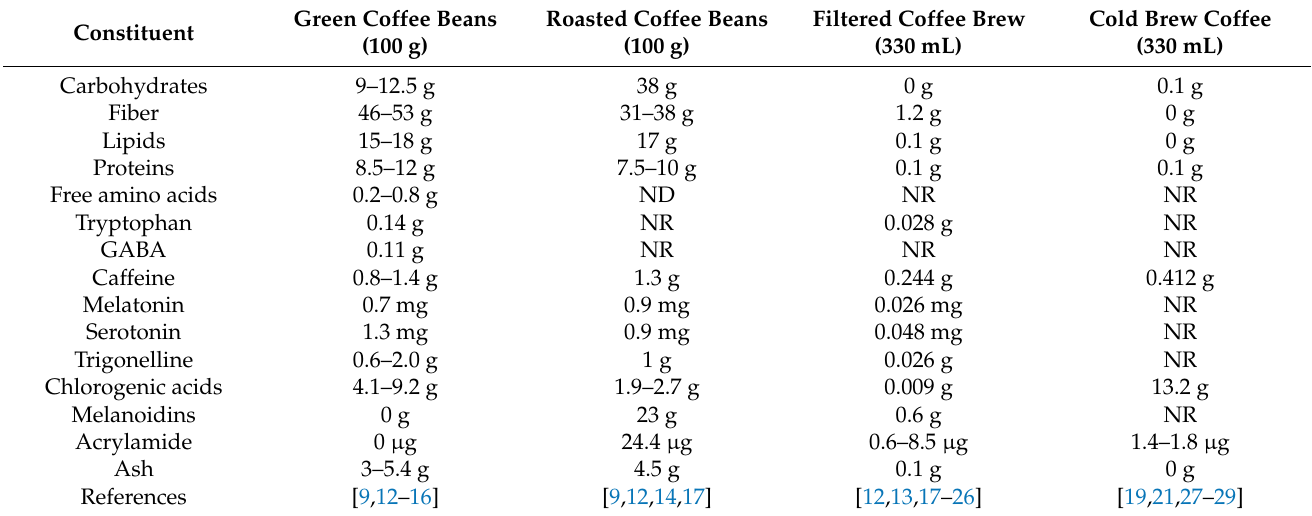
Table 1. Chemical composition of Arabica green, roasted, filtered, and cold brew